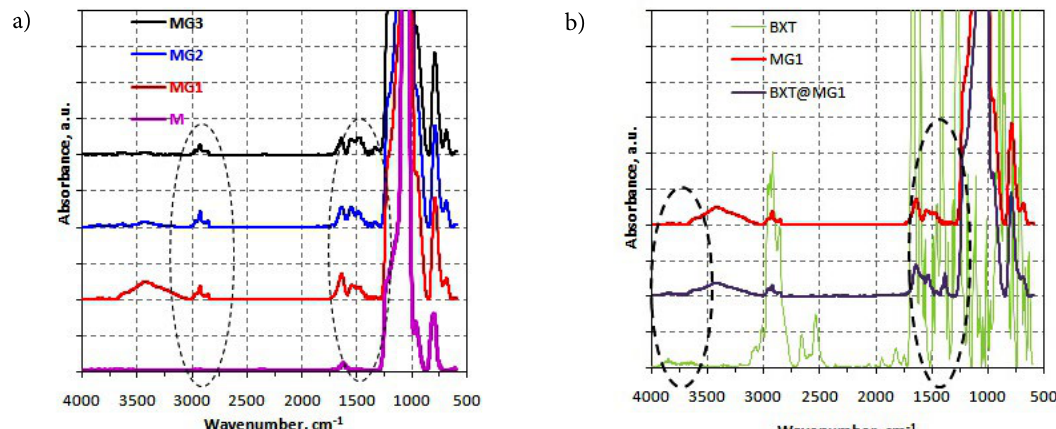
Figure 6. a) FTIR spectra for amino-functionalized MG to MG and BXT 1